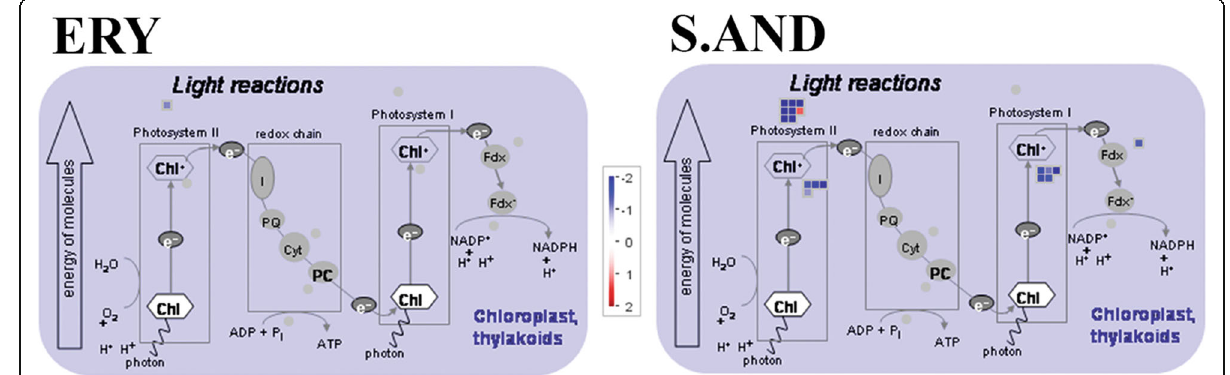
Fig. 5 Mapman analysis of cold-stress deregulated genes involved in photosynthesis. Specific up- and down-regulated genes (red and blue, respectively) in cold-stress post-meiotic anthers from ERY and S.AND cultivars were analysed by Mapman software (Thimm et al.